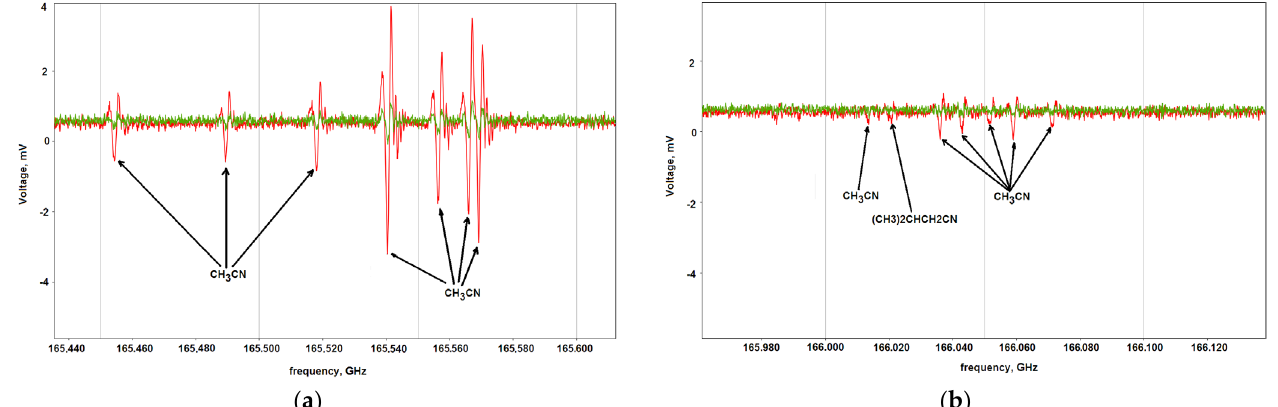
Figure 6. Record of the spectrum section containing absorption lines of methyl mercaptane (CH3SH) (f 1exp = 131.5656 GHz, f 1cat = 131.56548 GHz) for cyst sample (green curve), acetone (CH3COCH3) Table 1. The chemical composition of products of thermal decomposition and the average number (f 2exp = 131.5244 GHz, f 1cat = 131.52444 GHz), and propylene oxide (CH3CHCH2O) (f 3exp = 131.5508 GHz, f 3cat = 131.55101 GHz) for polyp (red curve), where f iexp are experimentally measured central of absorption lines for relatively healthy mucosa, polyps, and cysts. frequencies and f icat are frequencies from spectroscopy databases [11,12].